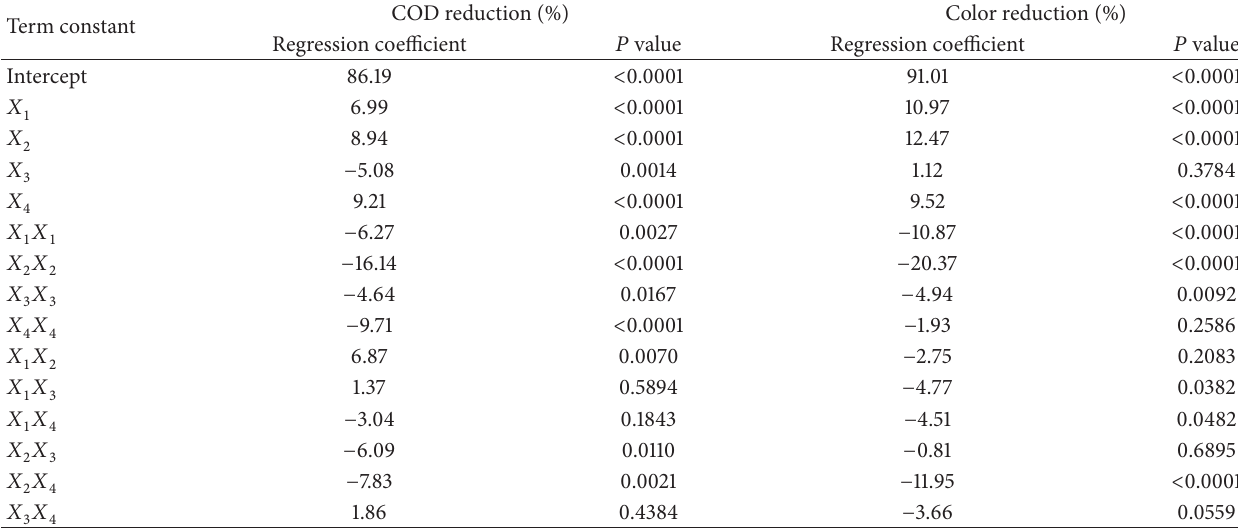
Table 4: Regression coefficients obtained by the response surface model.